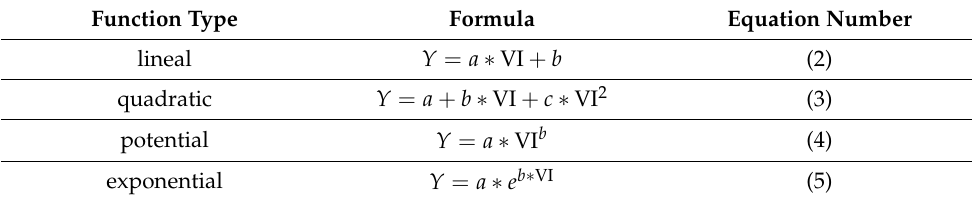
Table 6. Regression models maps considered in